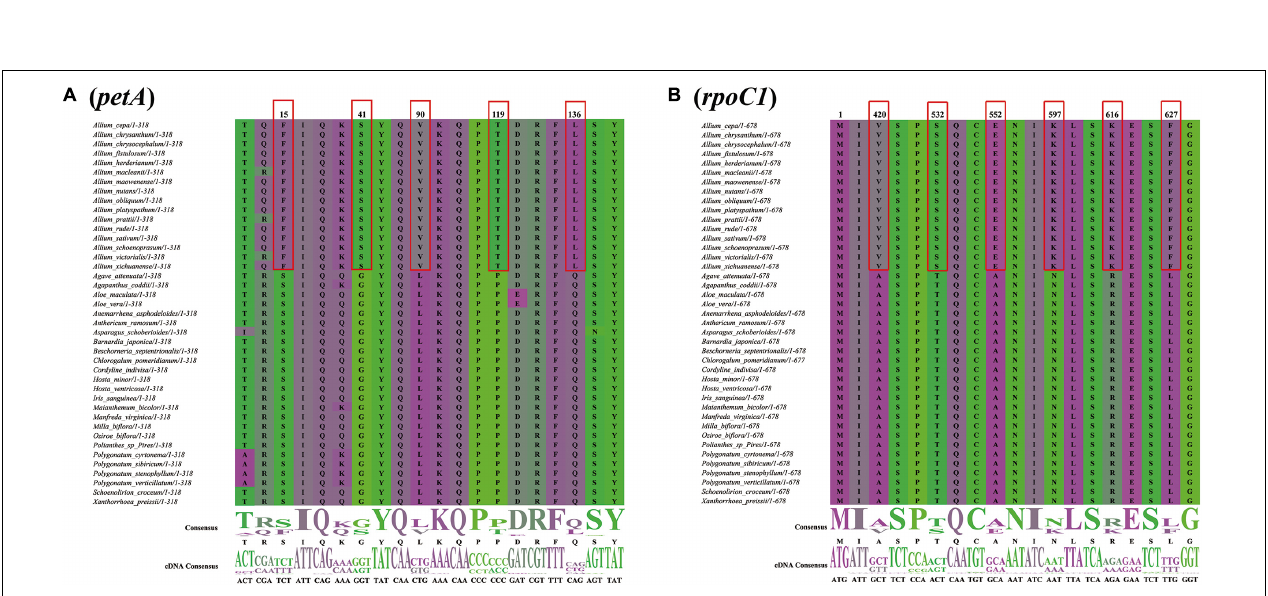
FIGURE 8 | Partial alignment of two out of 10 positively selected genes. (A) Partial aligned amino acids sequences of the petA gene; (B) partial aligned amino acids sequences of the rpoC1 gene. The red blocks stand for the amino acids in Allium (Allioideae) with a high BEB posterior probability.